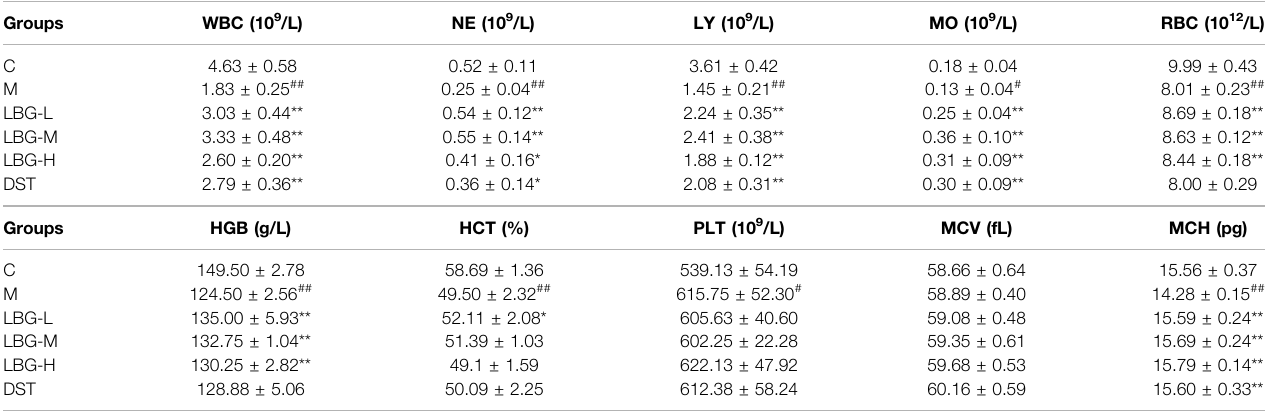
TABLE 1 | Changes in indexes of blood routine examination on leukopenia mice with LBG treatment ( n (cid:2) 8). Groups